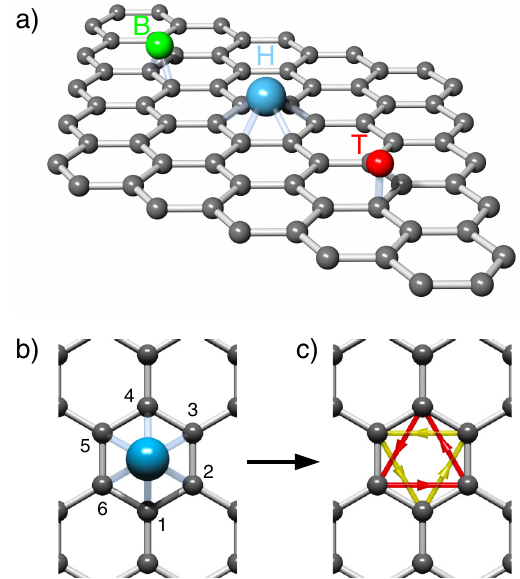
FIG. 1. Adatoms in graphene. (a) Depending on the element, adatoms favor either the high-symmetry ‘‘bridge’’ (B), ‘‘hollow’’ (H), or ‘‘top’’ (T) position in the graphene sheet. (b) Detailed view of an H-position adatom, which is best suited for inducing the intrinsic spin-orbit coupling necessary for stabilizing the topological phase. The desired spin-orbit terms mediated by the adatom are illustrated in (c). Red and yellow bonds represent the induced second-neighbor imaginary hopping, whose sign is indicated by the arrows for spin-up electrons. For spin-down electrons, the arrows are